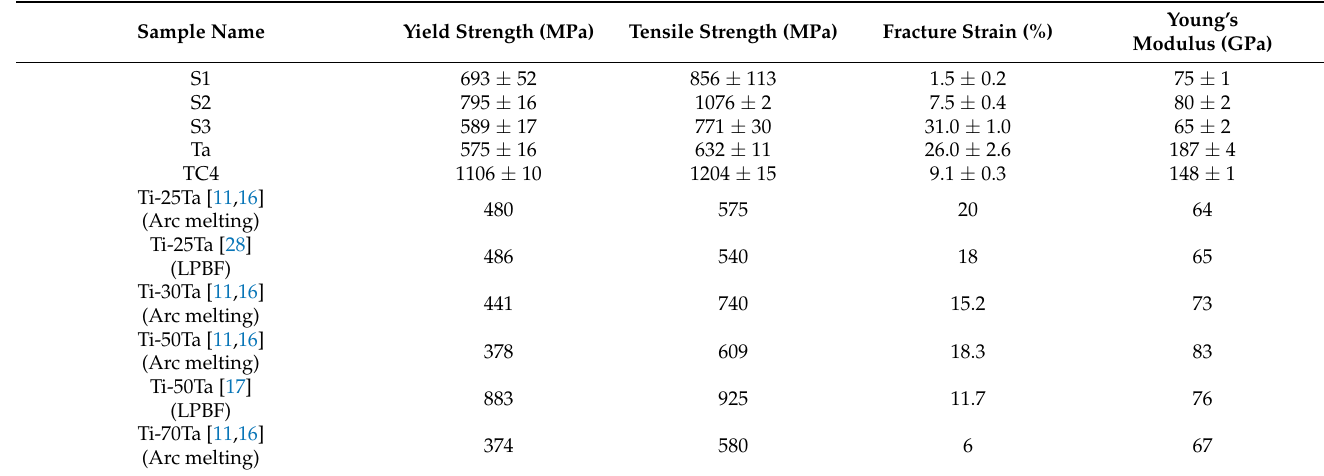
Table 5. The mechanical properties of Ti-Ta pure Ta and TC4 by